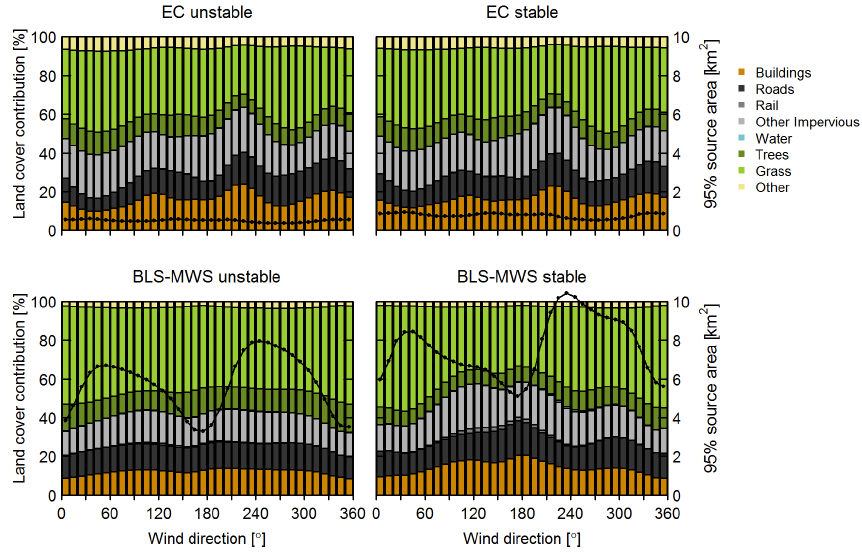
Figure 3. Contribution of land cover types to the EC and BLS–MWS source areas by wind direction for typical atmospheric conditions ( u ∗ = 0.5ms − 1 , σ v = 0.9ms − 1 , L Ob =± 200m). Black lines indicate the approximate size of the source area contributing 95% of the flux (right-hand